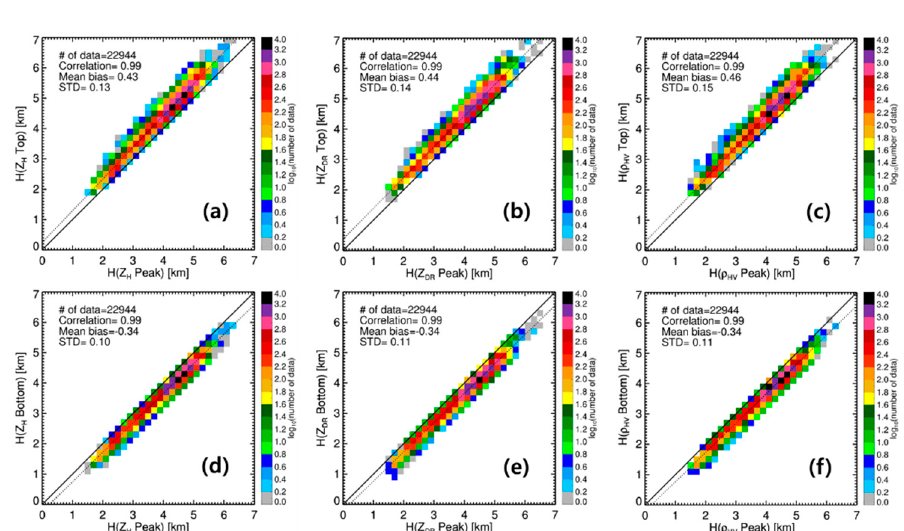
Figure 7. Two-dimensional frequency distributions. ( a ) Between H(Z H Top) and H(Z H Peak); ( b ) Between H(Z DR Top) and H(Z DR Peak); ( c ) Between H( ρ HV Top) and H( ρ HV Peak); ( d ) Between H(Z H Bottom) and H(Z H Peak); ( e ) Between H(Z DR Bottom) and H(Z DR Peak); and (f) between H( ρ HV Bottom) and H( ρ HV Peak).